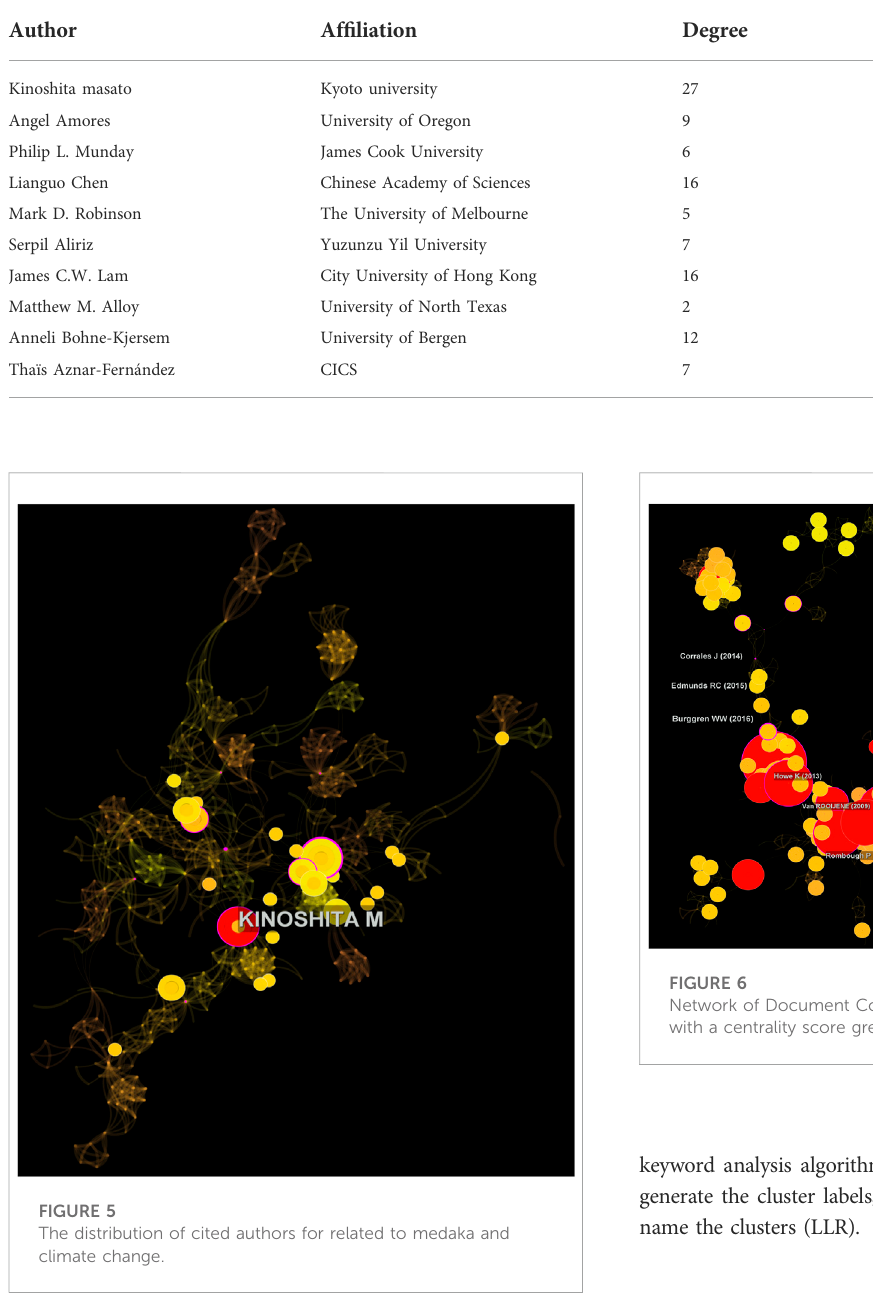
TABLE 6 Top 10 Authors co-citation score for research on Medaka and Climate Change.